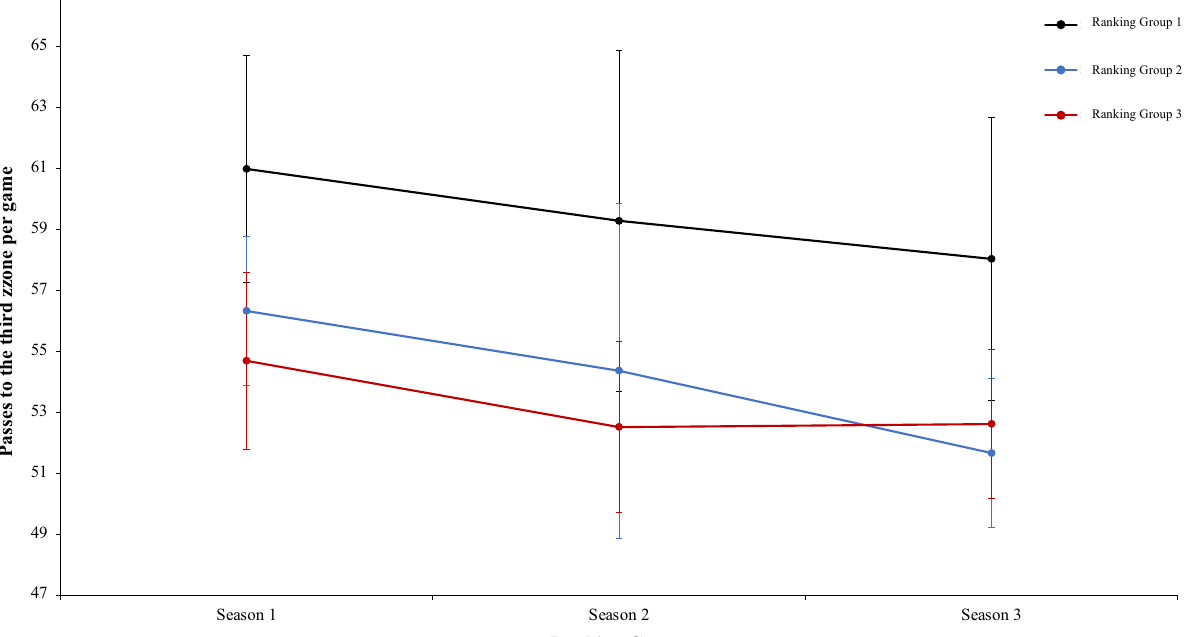
Figure 15. Technical performance. Mean passes to third zone (± SE) as a funtion of Ranking and Season